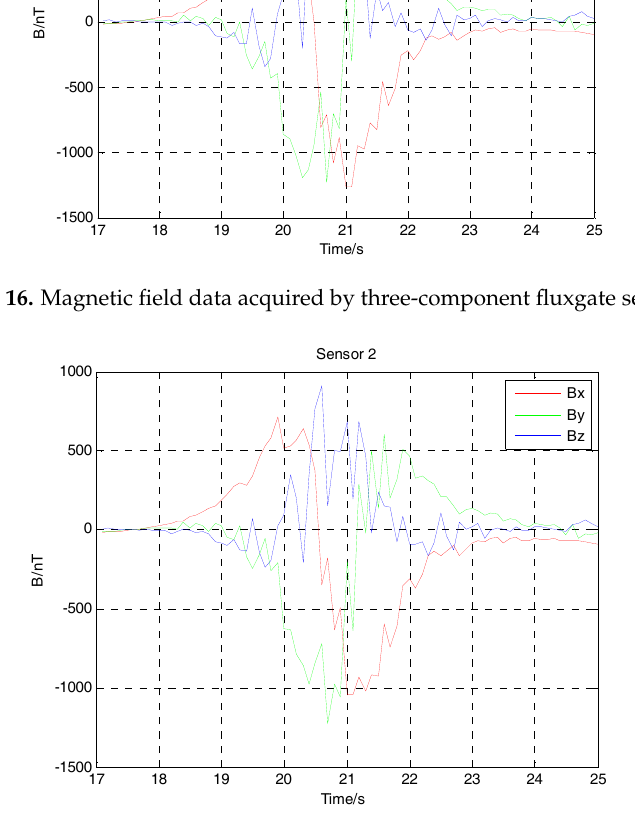
Figure 17. Magnetic field data acquired by three-component fluxgate sensor 2.